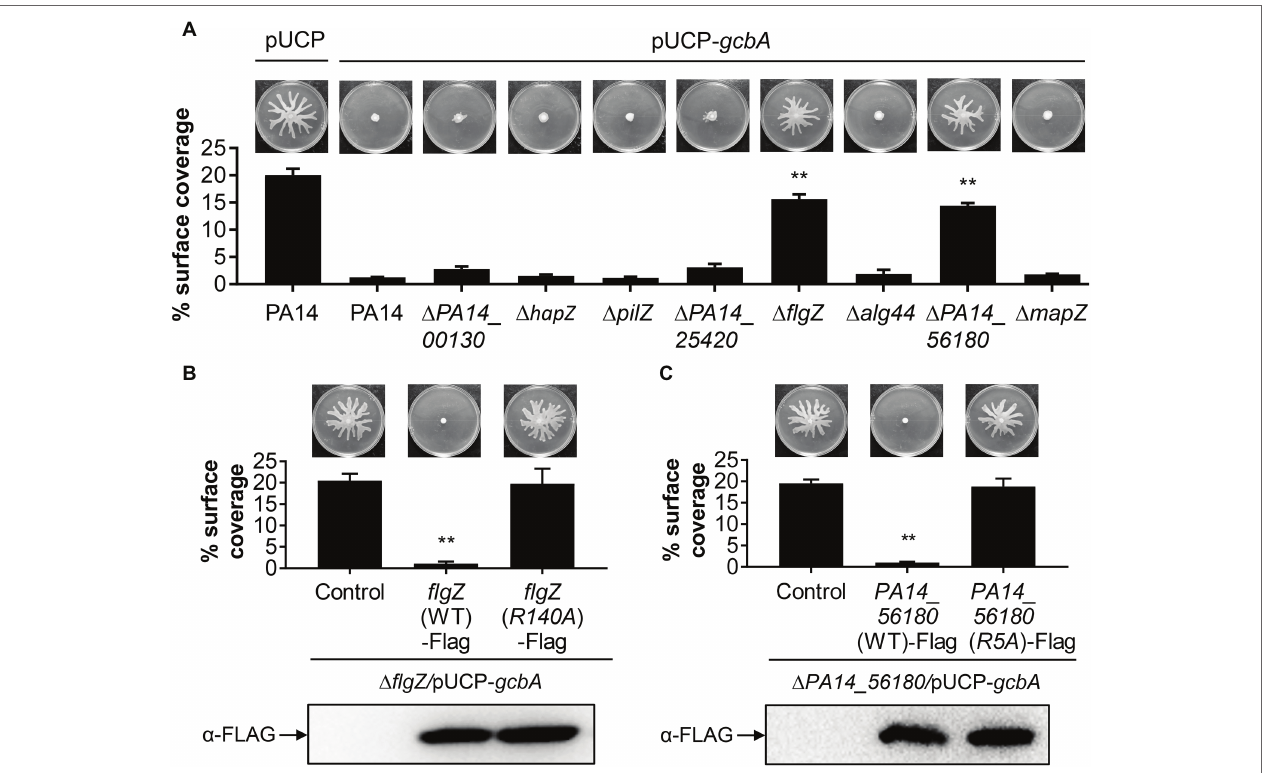
FIGURE 5 | FlgZ and PA14_56180 are required for GcbA c-di-GMP-mediated swarming repression. (A) Swarming phenotype and quantification of the percentages of plate surface coverage of the indicated strains carrying either the empty vector (pUCP) or the GcbA overproducing plasmid pUCP- gcbA . ** p < 0.01 (Student’s t -test, compared to PA14/pUCP- gcbA ). (B) Representative swarming plates (upper row) and average percentage of the plate coverage (middle row) by ∆ flgZ /pUCP- gcbA carrying the chromosomally encoded C-terminally FLAG-tagged WT FlgZ or FlgZ (R140A) under the control of the P BAD promoter at the att Tn 7 site. Significance was determined by Student’s t -test (** p < 0.01) relative to the vector control. Lower row: Western analysis of the FLAG-tagged FlgZ derivatives in indicated strains. Samples from equivalent number of bacterial cells were loaded onto SDS-PAGE gels and probed with anti-FLAG antibody. (C) Swarm analysis (upper row), quantification of percent coverage of swarm plates (middle row), and protein expression levels of FLAG-tagged derivatives of PA14_56180 (lower row) in ∆ PA14_56180 /pUCP- gcbA harboring the chromosomally encoded C-terminally FLAG-tagged WT PA14_56180 or PA14_56180 (R5A) as under panel (B)